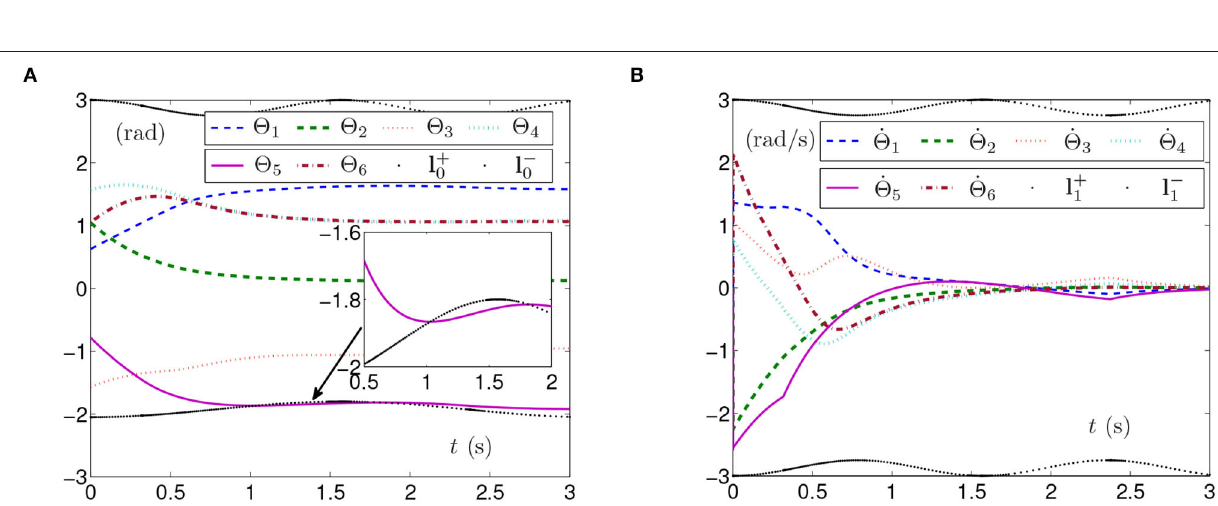
Frontiers in Neurorobotics |